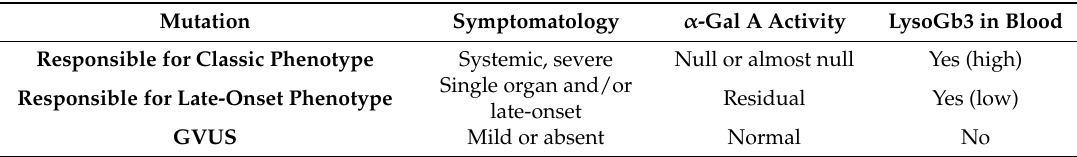
Table 6. Characteristics of subjects presenting a mutation in the GLA